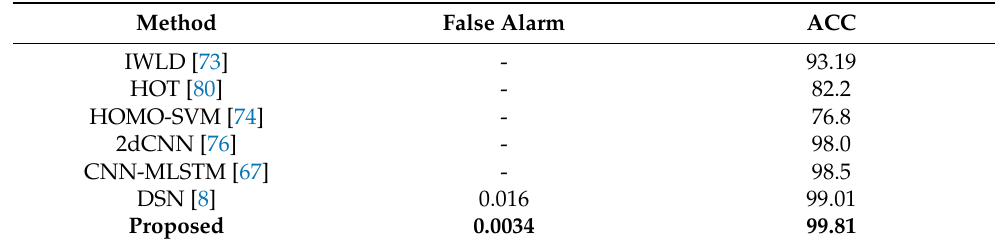
Table 5. Performance comparison of the proposed model with other SOTA over Violent Flow dataset. Method False